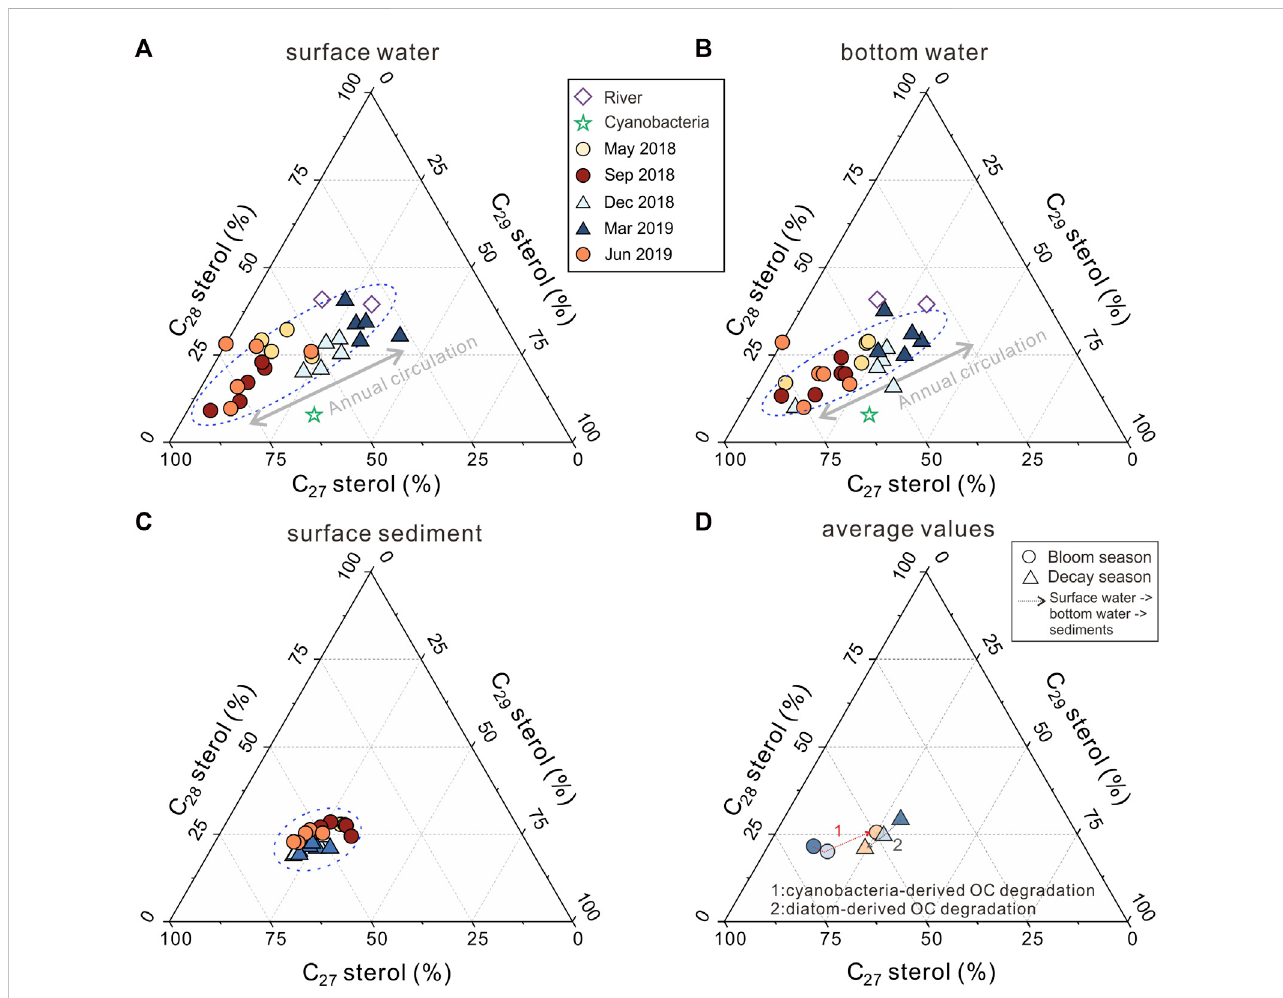
FIGURE 5 The seasonal variation of surface sediments and the overlying water column revealed by sterols. (A) sterols in surface water; (B) sterols in bottom water; (C) sterols in sediments; (D) average sterols in the water and sediments.